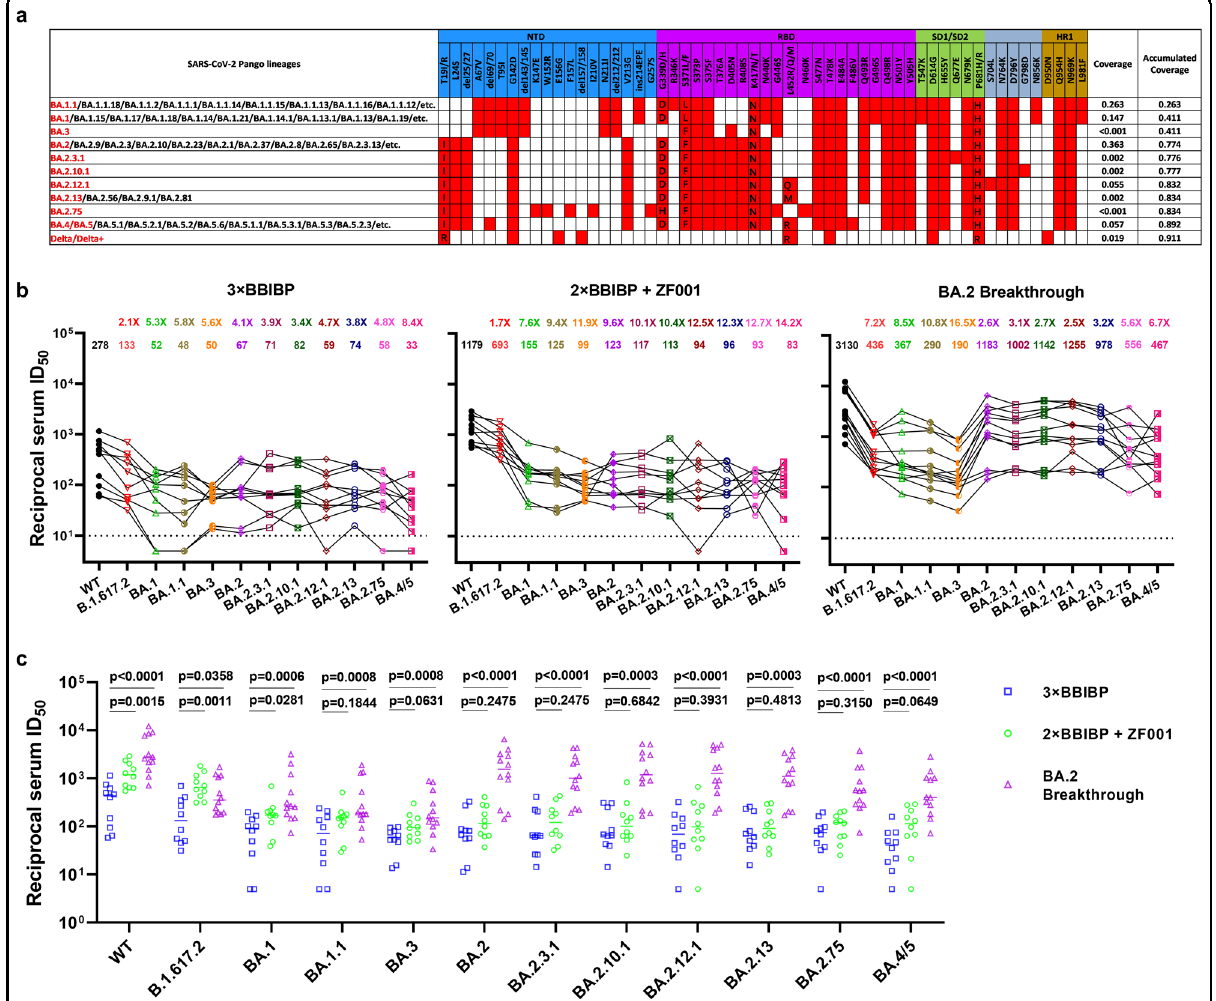
Fig. 1 Characteristics and sera neutralization of the Omicron sub-lineages. a Prevalence and spike mutations of the Omicron sub-lineages and Delta variant based on all the sequences available in GISAID since Jan 1st, 2022. Coverage indicates the total percentage of the indicated lineages in GISAID database. b Neutralization of pseudotyped WT (D614G), Delta and Omicron sub-lineage viruses by sera collected from individuals on day 14 after vaccination with a BBIBP-CorV homologous booster or with a ZF001 heterologous booster dose following two doses of BBIBP-CorV, or infection by BA.2 virus after three doses of BBIBP-CorV vaccination. For all panels, values above the symbols denote GMT and the fold-change was calculated by comparing the titer to WT. c In parallel comparison of neutralization titers against distinct SARS-CoV-2 variants by sera collected from individuals on day 14 after vaccination with homologous or heterologous booster, or breakthrough infection with BA.2 virus. P values were determined by multiple Mann-Whitney